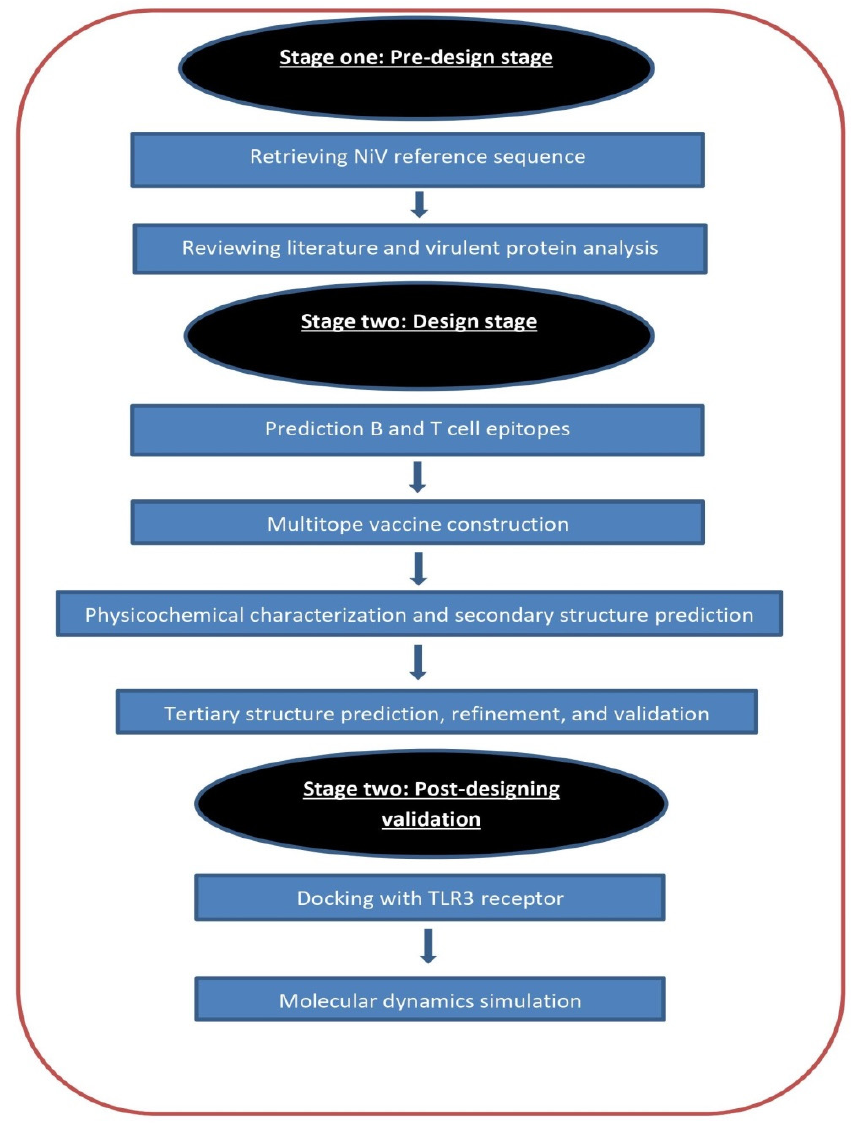
Figure 8. Graphical representation of the applied strategy for designing a chimeric epitope vaccine against Nipah virus.